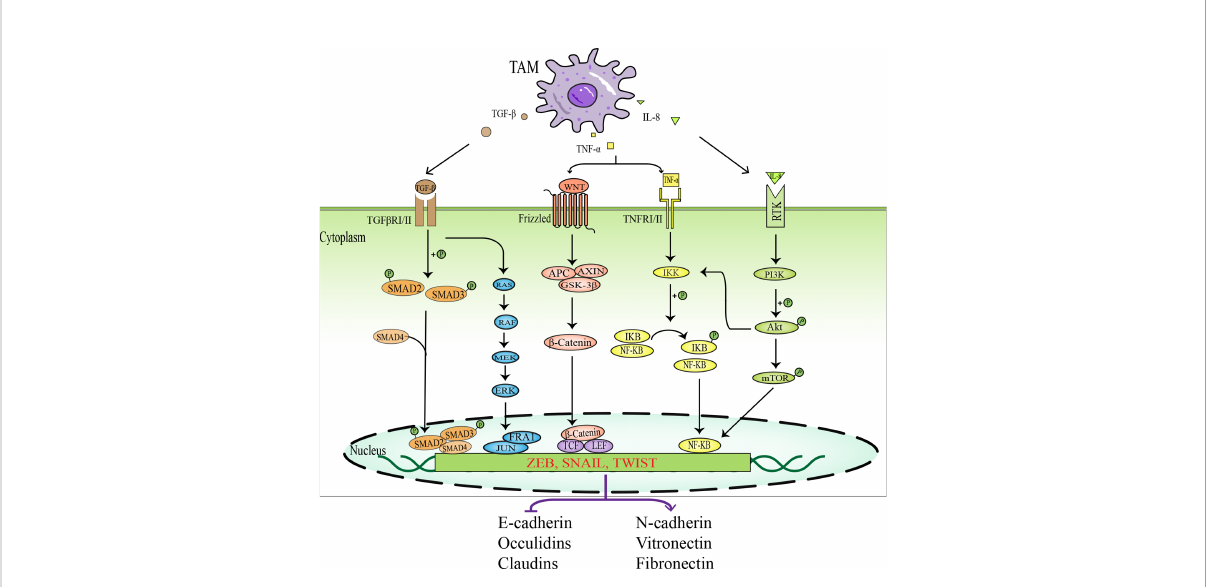
FIGURE 3 Schematic diagram of signal pathways in which TAMs promotes EMT in tumor cells. TAMs activate EMT- IF by secreting various factors, such as TGF- b , TNF- a , and IL-8, which act on intracellular related signaling pathways, including TGF- b - SMAD signaling pathway, MAPK signaling pathway, WNT- b -Catenin signaling pathway, NF-KB signaling pathway, and PI3K-AKT signaling pathway. EMT-IF can inhibit the expression of epithelial cell markers and promote the expression of mesenchymal cell markers, which leads to EMT in tumor